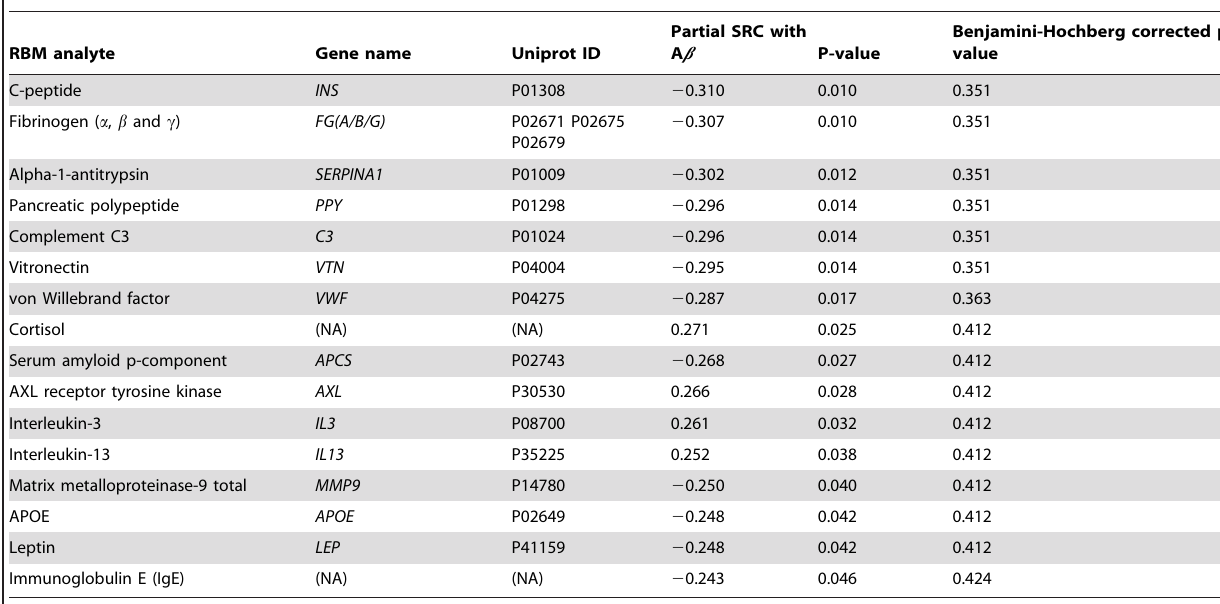
Table 2. RBM analytes associated with brain amyloid